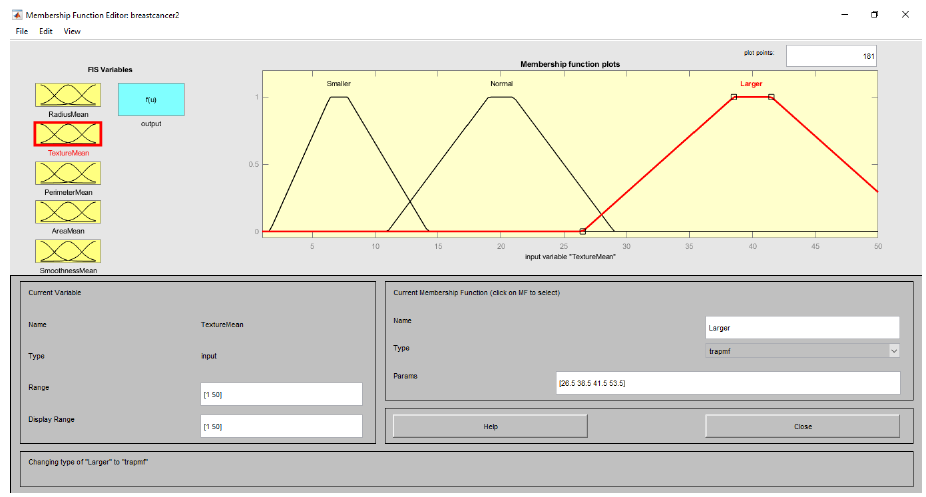
Figure 15. Membership functions of the linguistic variables of texture mean input.